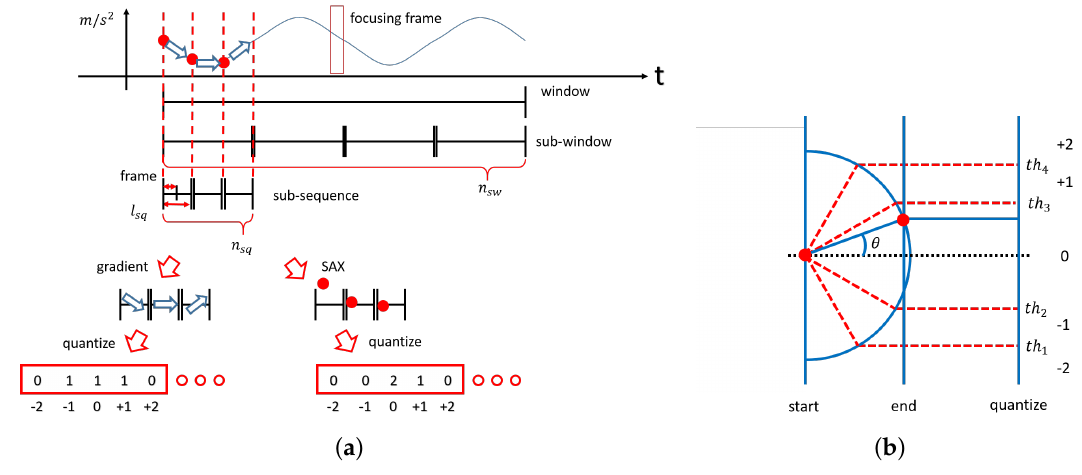
Figure 8. Diagrammatic depiction of the calculation of a feature vector. ( a ) Window for generating histograms; ( b ) gradient features quantized into five